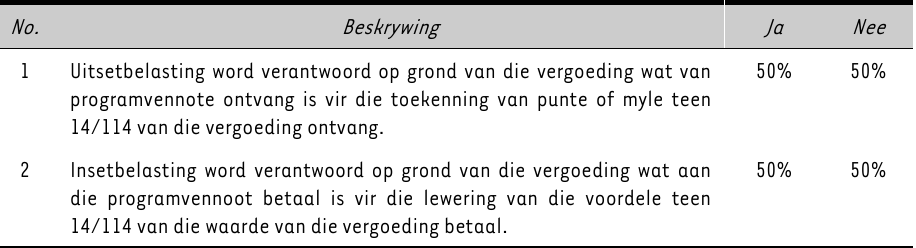
TABEL 11: Multivennootprogram met ‘n verskeidenheid programvennote